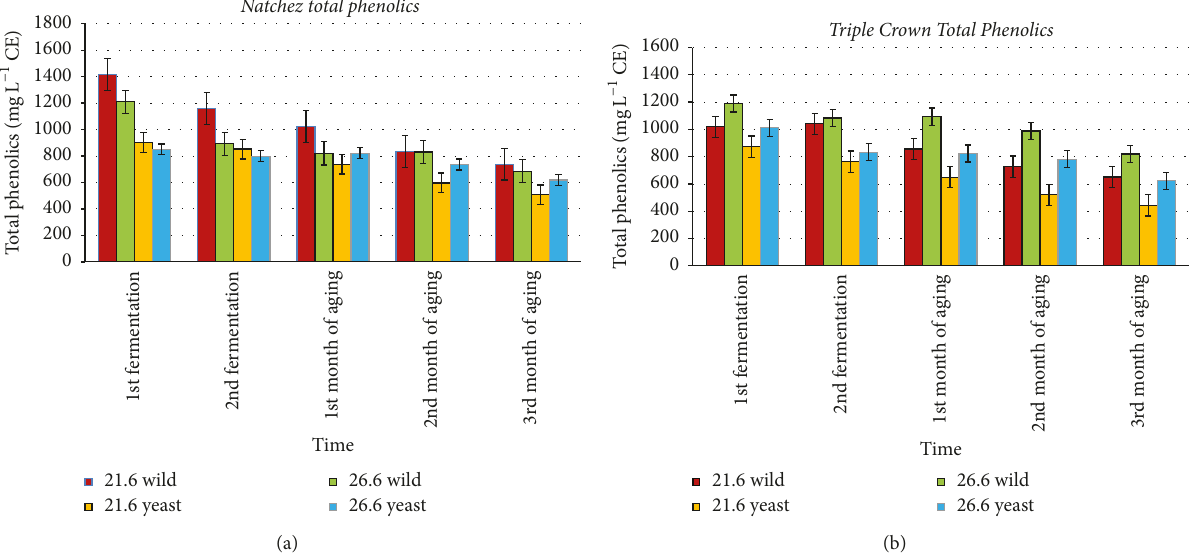
Figure 2: Total phenolic concentrations ( 𝑁 = 120 ) of “Natchez” blackberry (a) and “Triple Crown” blackberry (b) fermented juices and wines. Error bars represent ± standard deviation of the mean ( 𝑛 = 2